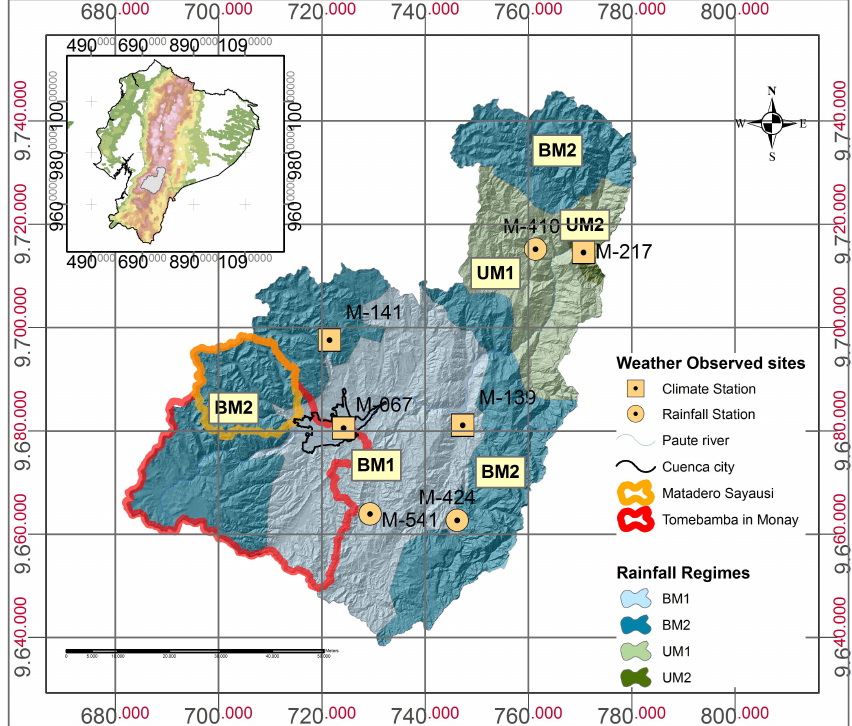
Fig. 1. Rainfall regimes in the Paute River basin (spatial regions BM1, BM2, UM1 and